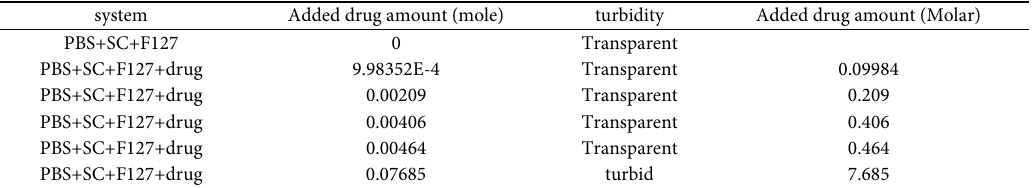
Table 5. The added drug to the micelle to determine the upper limit of solubilization of drug in F127 micelle ([F127]=0.009 M , [Sodium Caprylate (SC)]= 2.641 M).